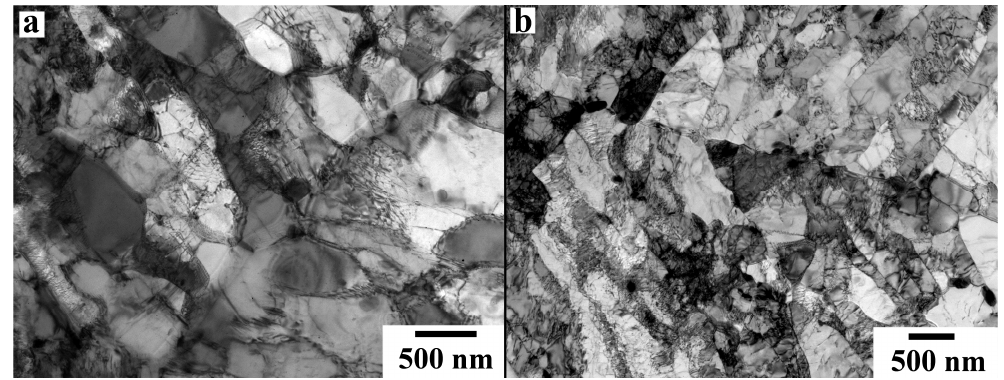
Figure 1. Mixed lath structure and subgrain one ( a ) in the 9Cr2W steel and homogeneous